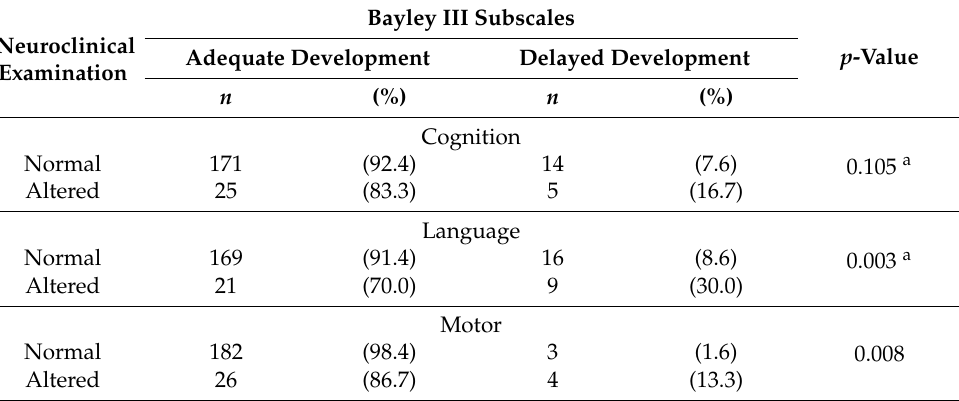
Table 4. Association between Bayley’s test and neuroclinical examination in the children with prenatal exposure to ZIKV born without